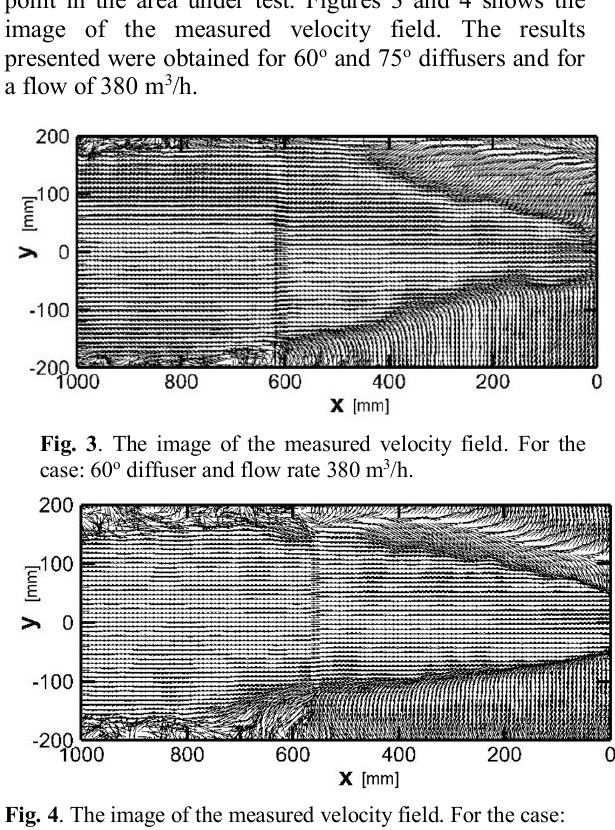
Fig. 4 . The image of the measured velocity field. For the case: 75 o diffuser and flow rate 380 m 3